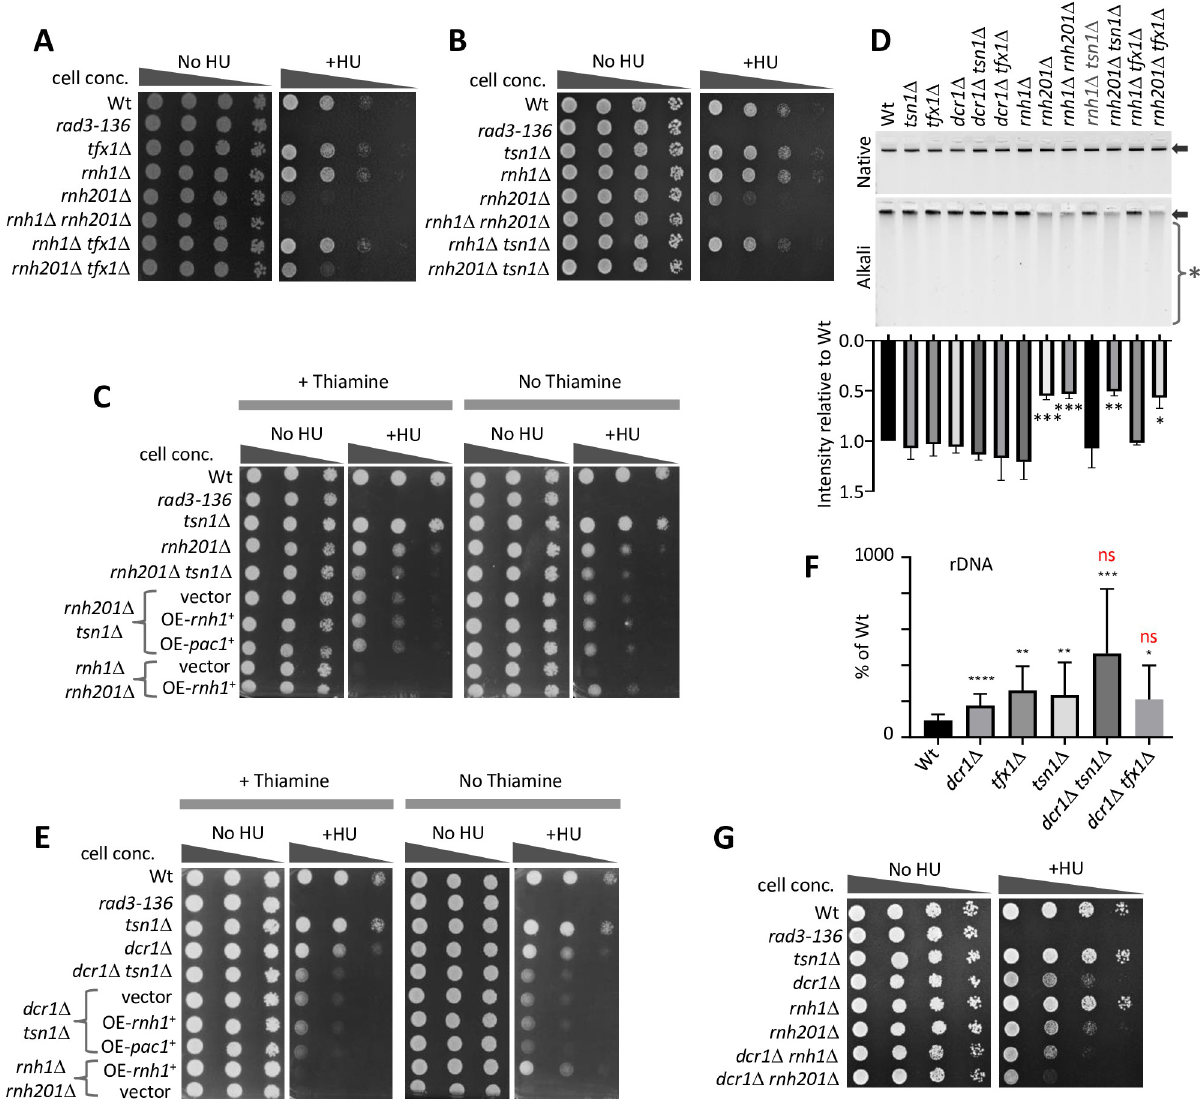
Fig 2. tsn1 + and dcr1 + are both functionally redundant with rnh201 . (A) 10-fold serial dilutions of indicated strains were spotted onto YEA with or without HU (10 mM). (B) 10-fold serial dilutions of indicated strains were spotted onto YEA with or without HU (10 mM). (C) 10-fold serial dilutions of indicated strains were spotted onto EMM with thiamine (with and without HU; 10 mM) or without thiamine (with or without HU;10 mM). OE– overexpression (RT-qPCR showing overexpression is shown in S3 Fig). (D) Top: Alkali and native gels showing genomic DNA extracted from the indicated strains. Arrows indicate the genomic DNA band and the single asterisk indicates the region of degraded genomic DNA. Bottom: Quantification of genomic DNA band intensity from the alkali gel (values normalized against the intensity of the chromosomal DNA band in the native gel). � P < 0.05, �� P < 0.01, ��� P < 0.001 from Student’s t -test in pairwise comparisons relative to wild-type. Bars represent standard deviation. Values are obtained from a minimum of three independent biological repeats. (E) 10-fold serial dilutions of indicated strains were spotted onto EMM with thiamine (with and without HU; 10 mM) or without thiamine (with or without HU;10 mM). OE–overexpression (RT-qPCR showing overexpression is shown in S3 Fig). (F) Quantification of DRIP for the rDNA (18S) locus for the indicated strains. � P < 0.05, �� P < 0.01, ��� P < 0.001, ns–not significant, from Student’s t -test in pairwise comparisons relative to relative to wild-type (black) or to dcr1 Δ (red). Bars represent standard deviation. Values are obtained from a minimum of three independent biological repeats. (G) 10-fold serial dilutions of indicated strains were spotted onto YEA with or without HU (10 mM). Note: distinct relative sensitivities are observed when mutants are grown on minimal media (EMM) vs . rich media (YEA), which is due to distinct growth rates. OE-Sp tsn+ —overexpressed S . pombe tsn1 + ; OE-Sp tsn1-E152A – overexpression of S . pombe tsn1 + mutated at sole the residue conserved with the Tfx1 (and TSNAX) RNase catalytic domain.